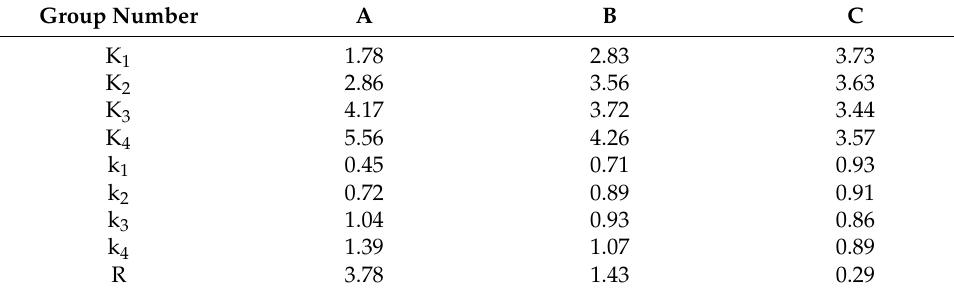
Table 6. UCS range calculation table for fiber cement